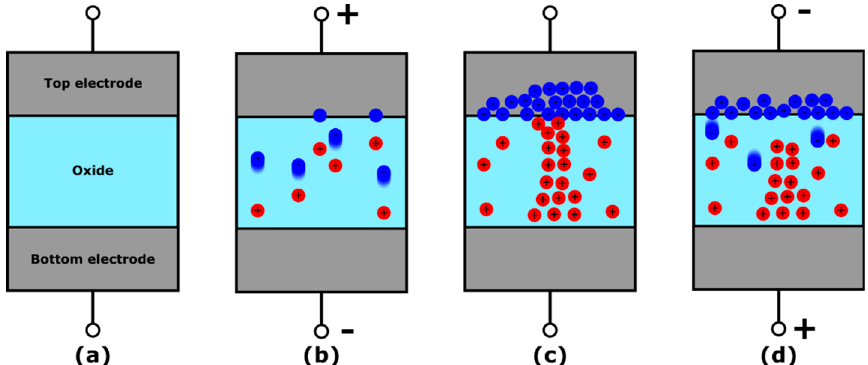
Figure 1. Structure and operation of a filamentary OxRAM device. ( a ) Device in pristine conditions. ( b ) Forming operation: a positive voltage is applied to the top electrode, generating oxygen ion/vacancy pairs. The ions (blue spheres) migrate under the effect of the electric field, leaving the oxygen vacancies (red spheres) behind. ( c ) Formed device with a conductive filament (CF) made of oxygen vacancies connecting the two electrodes. ( d ) Reset operation: a negative voltage is applied to the top electrode, bringing the oxygen ions near to the oxygen vacancies. The resulting recombination leads to partial dissolution of the CF and the formation of a dielectric barrier.